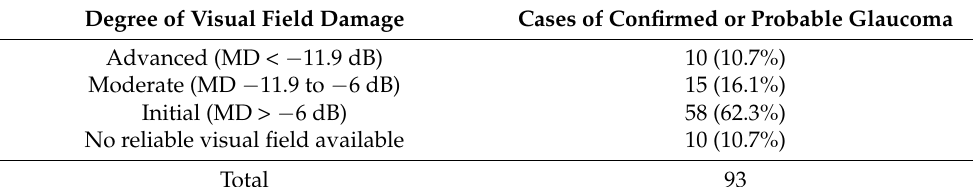
Table 2. Degree of glaucoma according to mean visual field defect. Degree of Visual Field